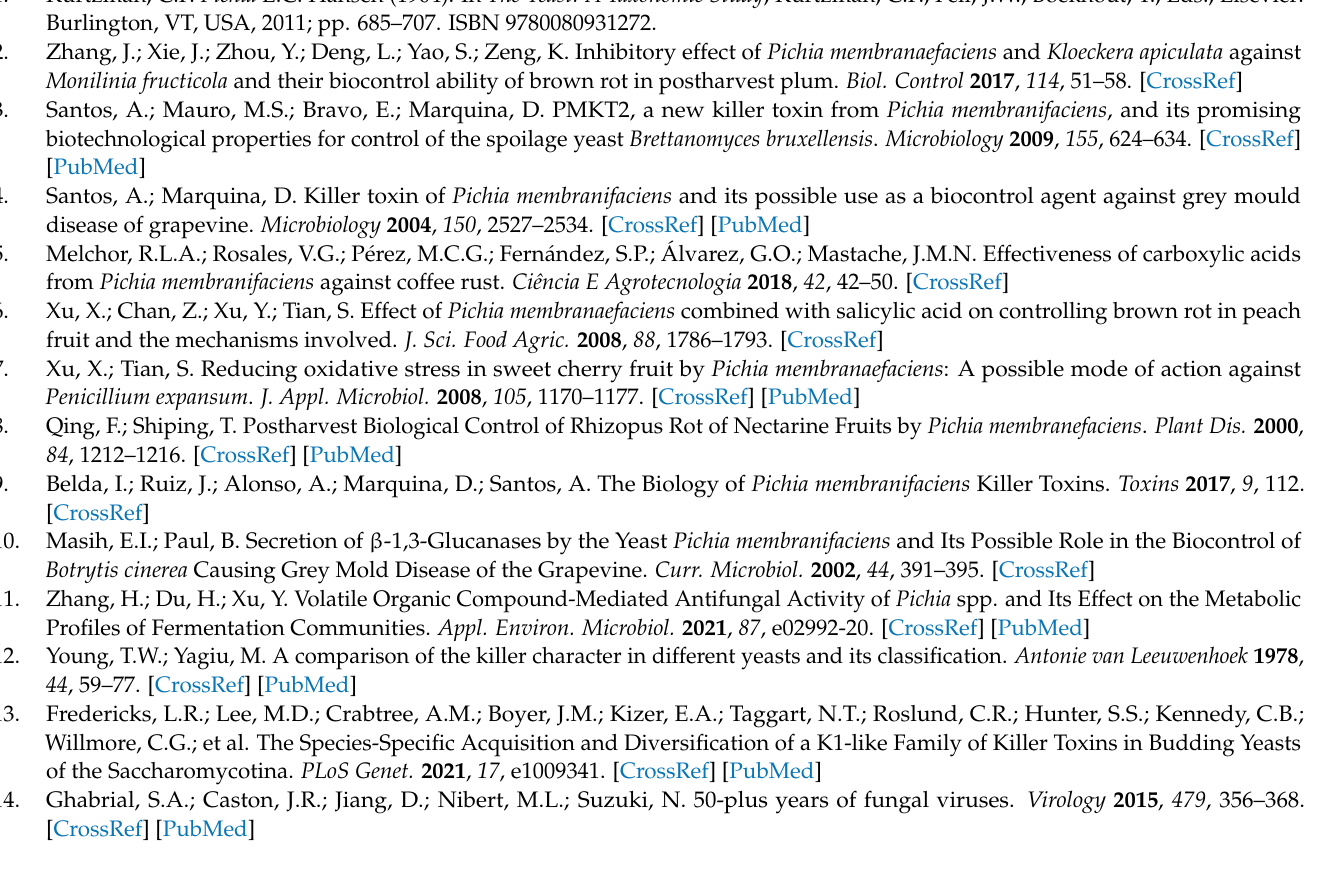
Figure 4D and Nathan Taggart for the critical reading of the